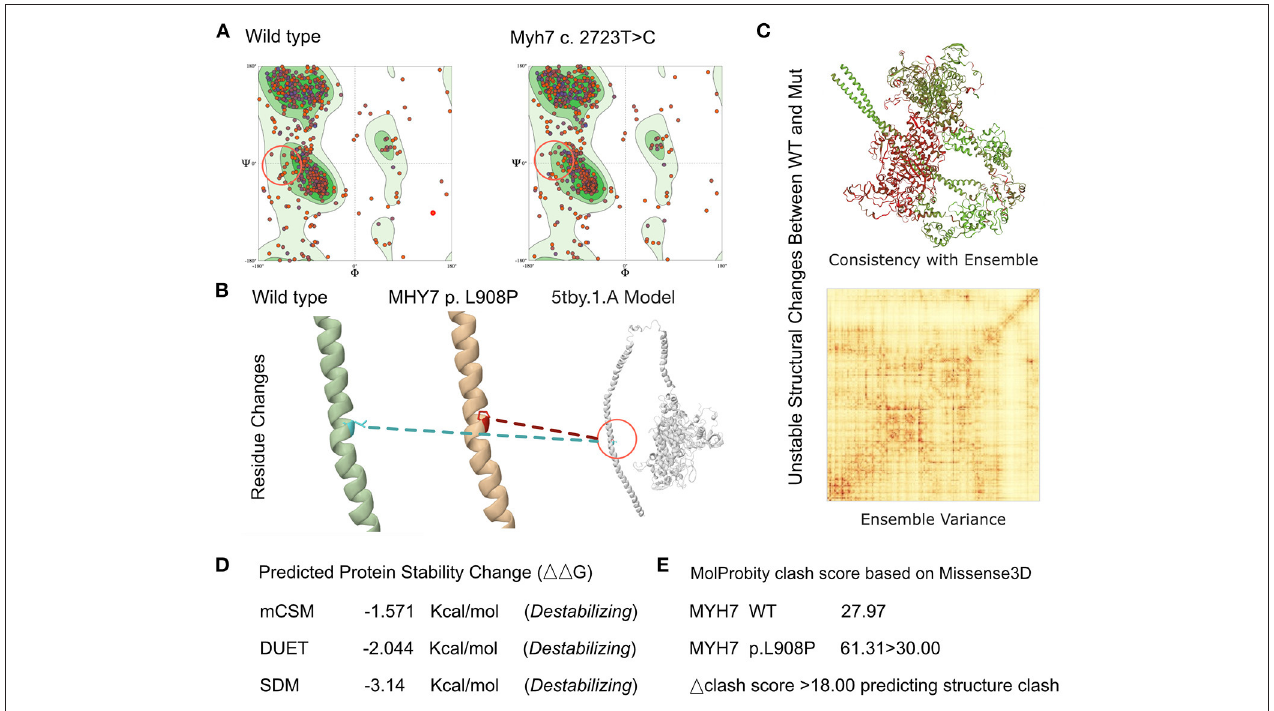
FIGURE 2 | Effects of MYH7 c.2723T > C mutation on molecular protein structure. (A) Ramachandran plots of MYH7 with and without p.L908P mutation. (B) SWISS-MODEL to predict the variant’s wild-type and mutated protein crystal structures using 5tby.1.A template, and structural changes identified in the helix. (C,D) The mCSM tool used to predict protein stability revealed a decline in Gibbs free energy, indicating an unstable protein structure associated with this mutation. (E) Missense 3D analysis indicated that MYH7 p.L908P caused a structure clash.